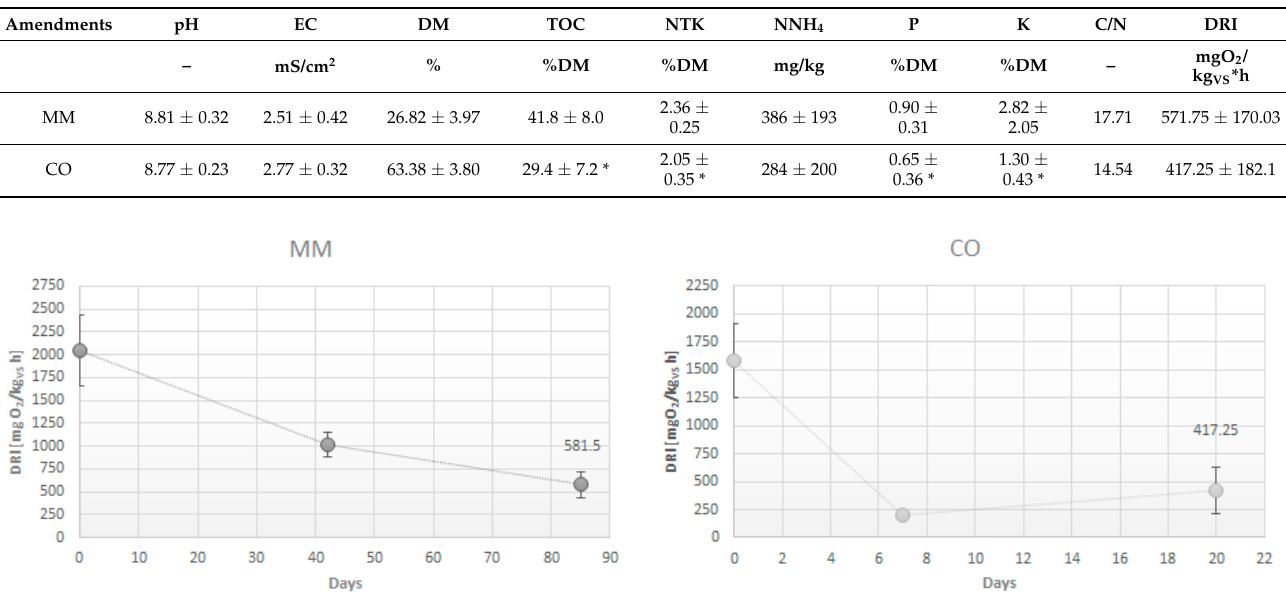
Figure 1. Oxygen uptake rate evolution during the maturation process (for MM) and composting (for CO).